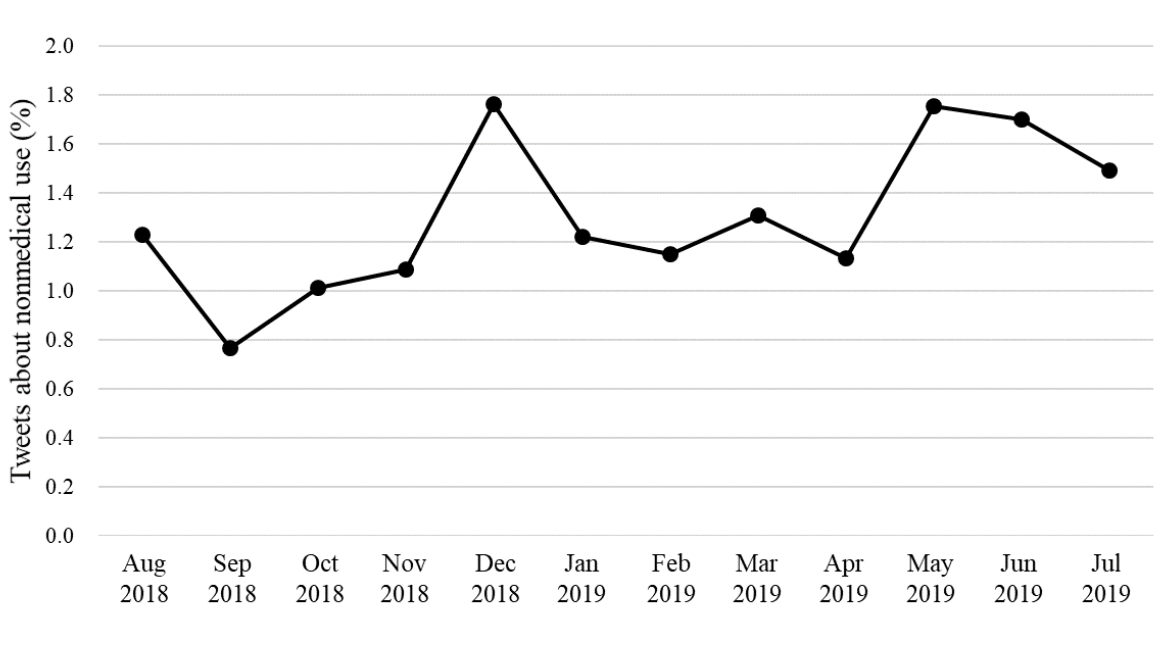
Figure 2. Distribution of tweets about nonmedical use of methylphenidate, by